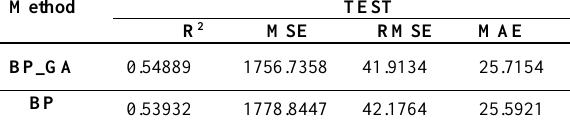
Table 5. Evaluation of BP, BP-GA (Test phase).